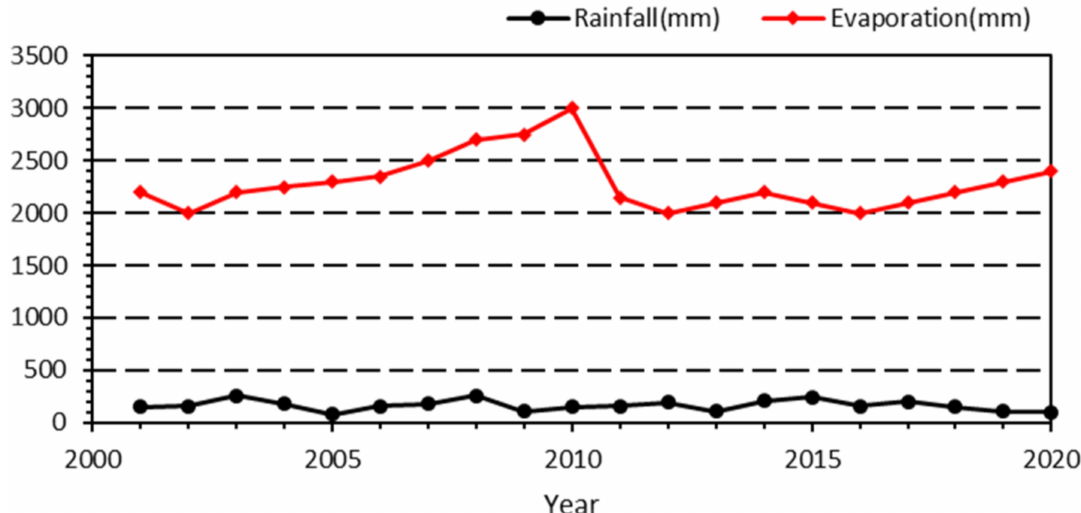
Figure 3. Changes of rainfall and